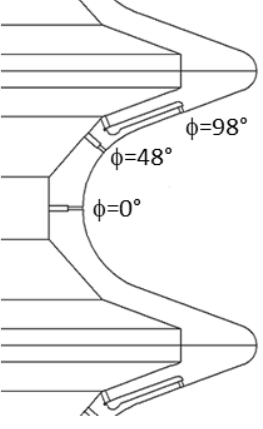
Figure 3. Schematic of side wall pressure taps.